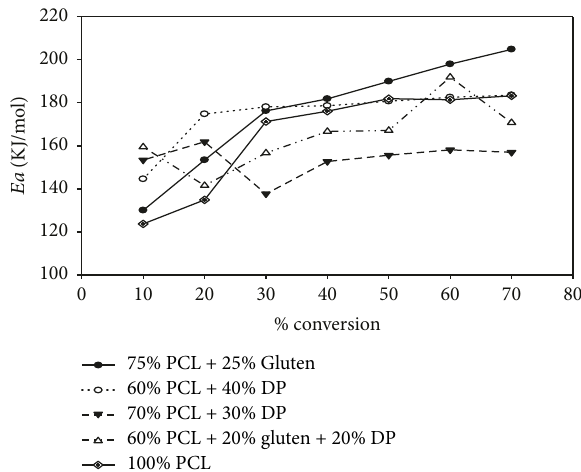
Figure 13: Degradation mechanism of different PCL composites.